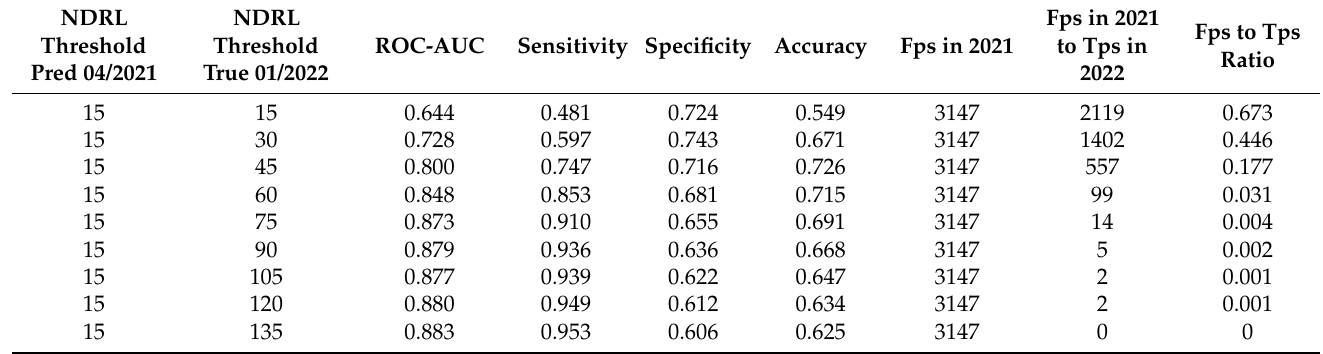
Table 1. Performance metrics of models trained with data from 19 April 2021 and evaluated with data from 6 January 2022. This table shows the metrics (ROC-AUC, sensitivity, specificity, accuracy), false positives from 2021 (fps in 2021) that turn into true positives (fps in 2021 to tps in 2022), and the proportion of this conversion (fps to tps ratio) using different NDRL thresholds for the data from 2022 (th true January